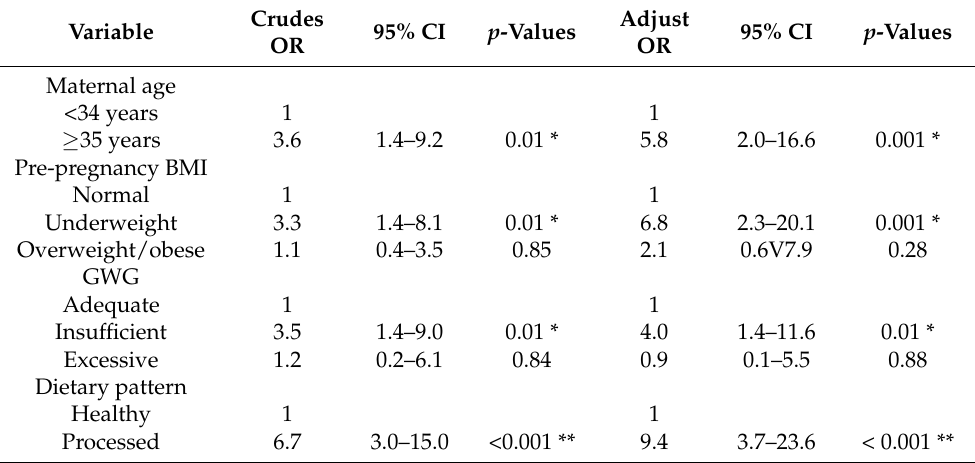
Table 4. Multiple logistic regression model for low birth weights (N =